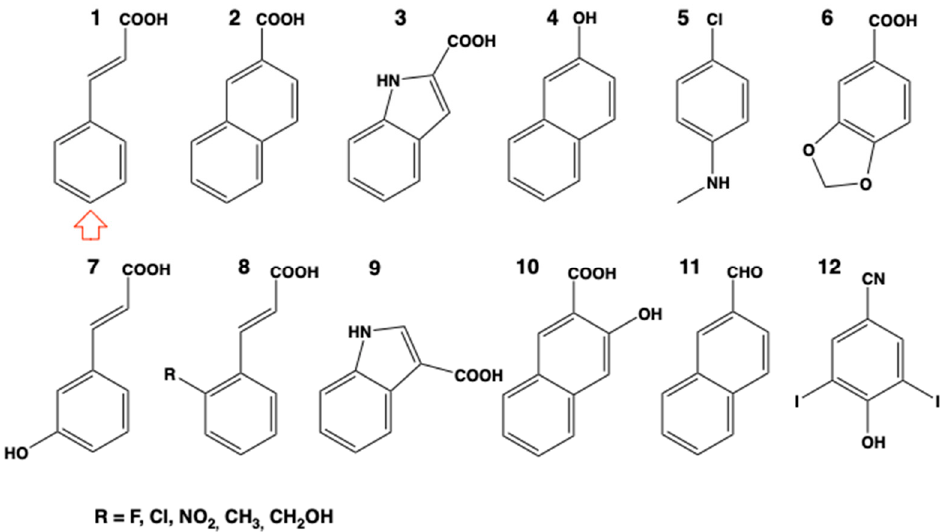
Figure 5. Substrate permissiveness and representative substrates and inhibitors of the highly conserved CYP73 in plant phenolic metabolism. Red arrow indicates the site of oxidative attack when determined: 1 : cinnamic acid (natural substrate); 2 : 2-naphtoic acid (hydroxylated with efficiency similar to cinnamic acid, used as a fluorescent reporter of CYP73 activity); 3 : indole-2-carboxylic acid; 4 : 2-naphtol; 5 : p -chloro- N -methylaniline; 6 : piperonylic acid (suicide substrate since attacked on methylene dioxo, used as a specific inhibitor of CYP73 in planta ); 7 : m -coumaric acid; 8 : o -sustituted-cinnamic acids; 9 : indole-3-carboxylic acid; 10 : 1-hydroxy-2-naphtoic acid; 11 : 2-naphtaldehyde; 12 : ioxynil (herbicide not converted but ligand and competitive inhibitor ( K i = 2 μ M)). Only m -coumaric acid, indole 3-carboxylic acid and piperonylic acid (extracted from bark of Orotea pseudo-coto ) are natural plant compounds. Indole 3-carboxylic acid is reported to be present in high amounts in Arabidopsis [42] is converted with low efficiency. So far, no major variation in CYP73 substrate preference has been reported at any stage of the plant evolution, nor resulting from enzyme duplication.